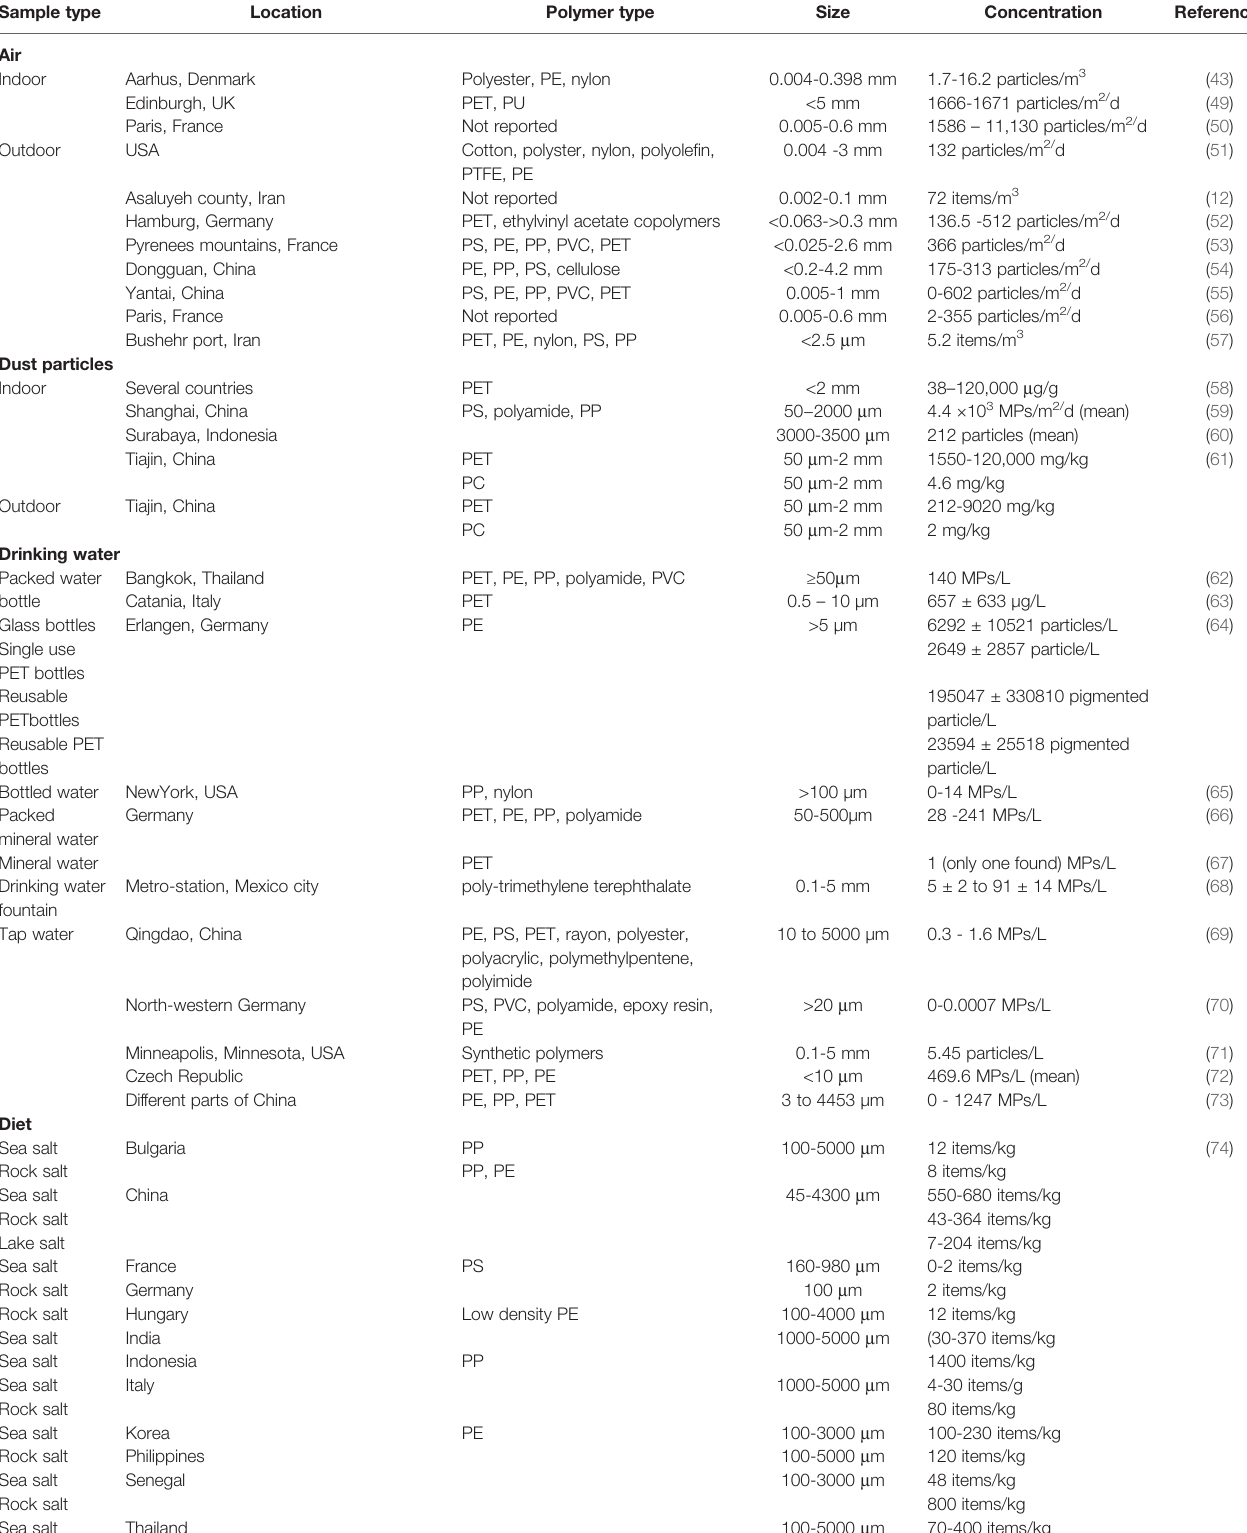
TABLE 1 | Reported concentrations of microplastics in air, dust, drinking water, sea food, food, beverages and human samples. Sample